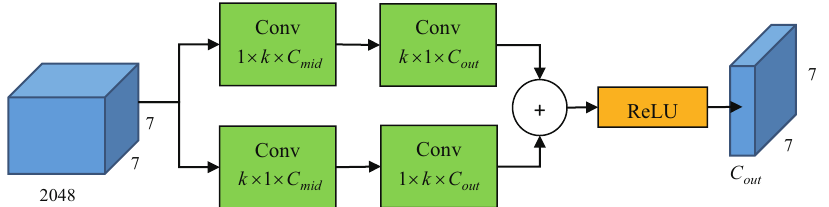
Figure 7. Large-kernel separable convolution performs a k × 1 and 1 × k convolution sequentially. The number of parameters can be controlled through alternating C mid and C out .